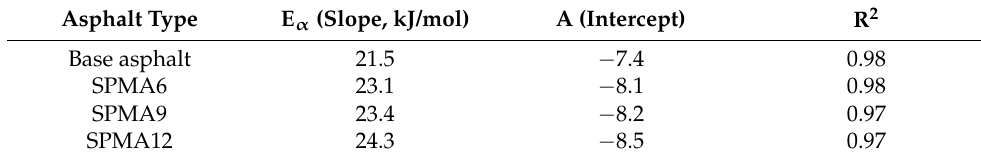
Table 13. The fitting result of activation